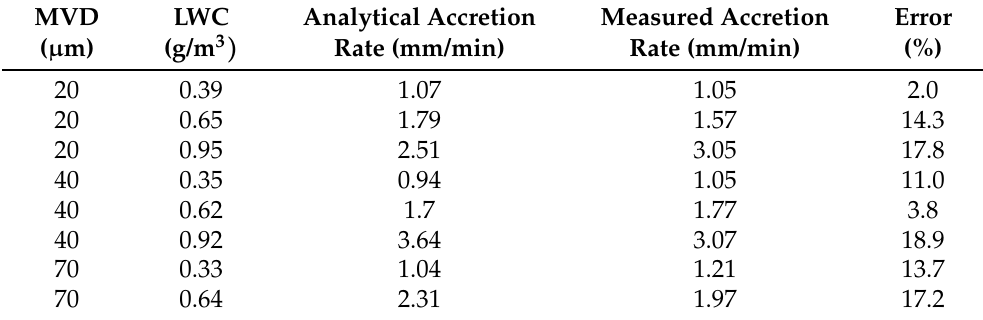
Table 6. Ice Accretion Rate